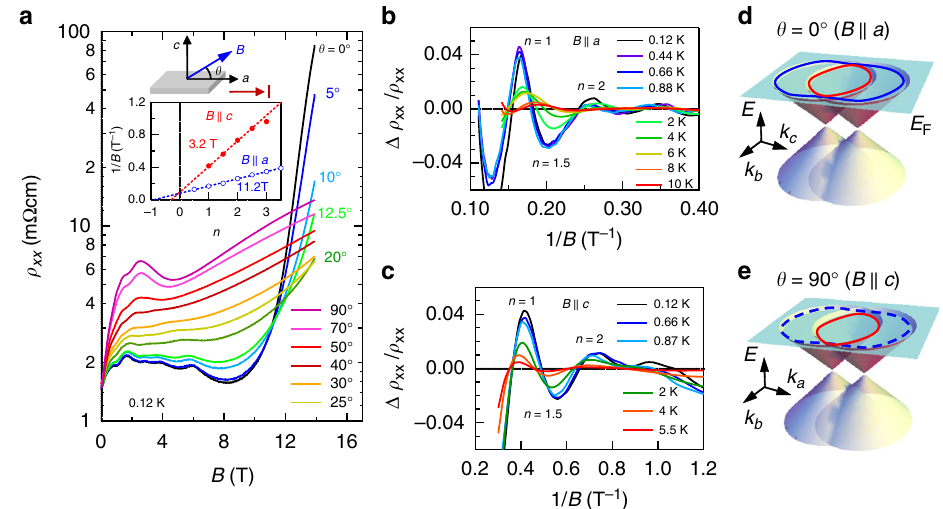
Fig. 2 Shubnikov – de-Haas (SdH) oscillations and giant positive magnetoresistivity. a The angular dependence of resistivity ρ xx at 0.12 K. The SdH oscillation for 2 – 9 T is clear for B || a , while that for 1 – 3 T is clear even for B || c . The giant positive magnetoresistivity is observed above 9 T nearby B || a . Inset shows the Landau index plot of the oscillation for B || a and B || c and illustration of measurement geometry for B and electrical current I (|| a ). The tilting angle θ is de fi ned as zero for B || a . b , c Oscillatory component at various temperatures for B || a and for B || c . d , e Illustration of band dispersion nearby the line node described in k b – k c plane and k a – k b plane. The red and blue line denotes the cross-section of inner- and outer-Fermi surface (FS), respectively. The SdH oscillation of outer-FS is not visible for B || c , which is indicated by dashed lines